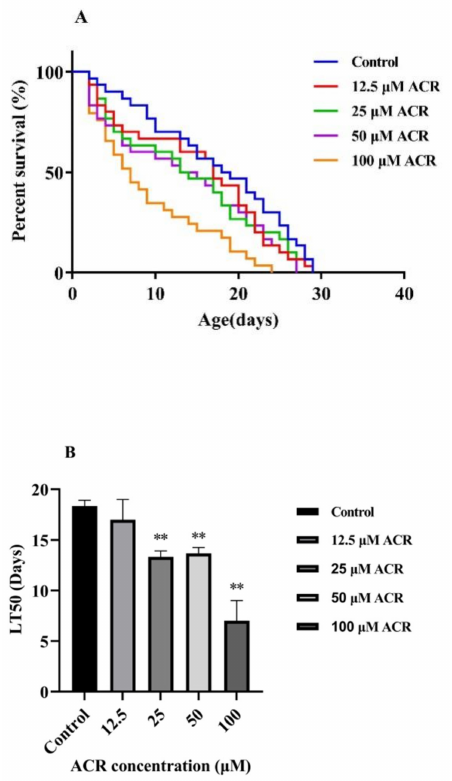
Figure 1. Effect of ACR exposure (12.5, 25, 50, and 100 µ M for 48 h) on lifespan ( A ) and median lethal time ( B ) of N2 nematodes. Values are means ± SD. **Compared with the control group p < 0.01. Table 1. Effect of ACR exposure on the lifespan in of N2 nematodes.